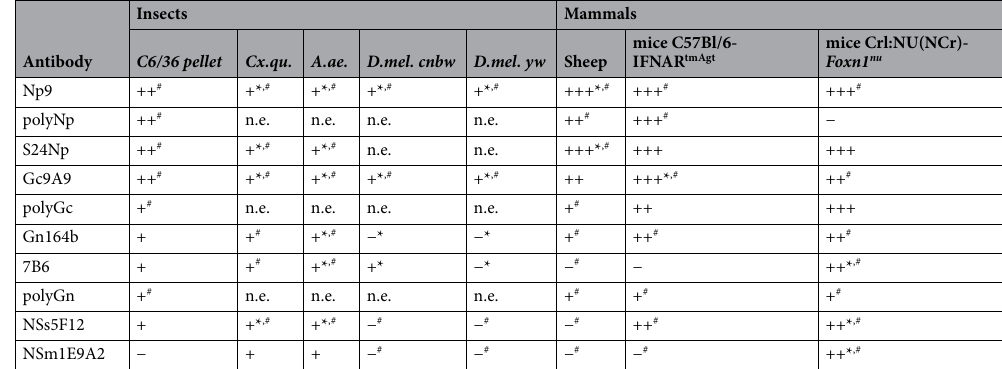
Table 2. Immunopositive signals in RVFV-infected specimens. A.ae.: Aedes aegypti; Cx.qu.: Culex pipiens quinquefasciatus; D.mel. cnbw: Drosophila melanogaster cinnabar brown; D.mel. yw: Drosophila melanogaster yellow-white; n.a.: not assessed; n.e.: not evaluable; +: positive reaction in insect tissue, low numbers (< 30%) of positive cells in mammals and C6/36 cell pellet; ++: moderate numbers (30–60%) of positive cells in mammals and C6/36 cell pellet; +++: high numbers (> 60%) of positive cells in mammals and C6/36 cell pellet; −: no reaction; *: false positive labeling in non-infected specimens; #: unspecific background of varying